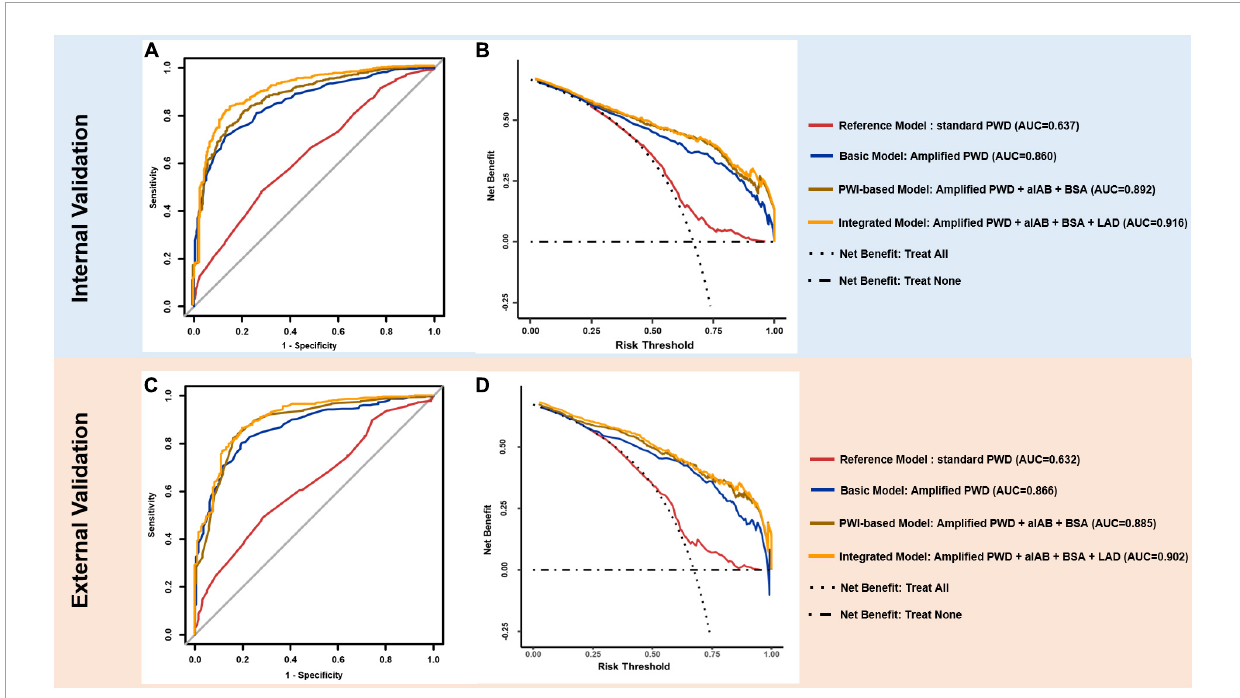
FIGURE4 ROC and DCA curves. In internal (upper panel) and external validation (lower panel), ROC curves of reference model (red), basic model (blue), PWI-based model (brown) and integrated model (yellow) are plotted (A,C) with model components and AUC value annotated at right side. DCA (B,D) illustrates the clinical impact (net benefit) of diagnostic model with reference curves of “Treat All” and “Treat None” . “Treat All” and “Treat None” described the impact of intervention for “All” and “None” of individuals for target outcome (AF) respectively, when diagnostic model is not applied. ROC, receiver operating characteristics; AUC, area under the curve; DCA, decision curve analysis; PWD, p-wave